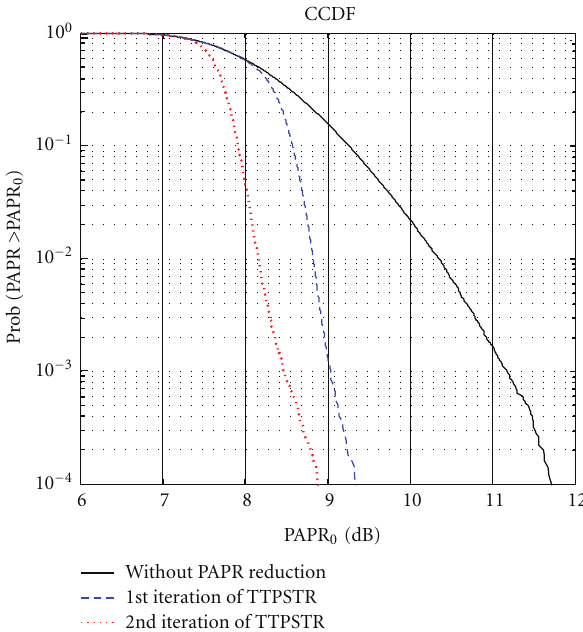
Figure 9: CCDF plots of a WiMAX signal before and after PAPR